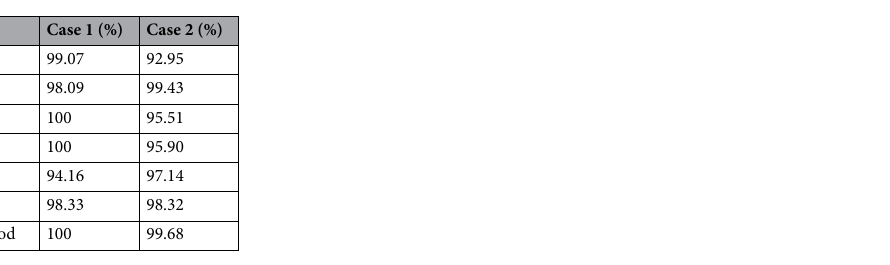
Table 6. Comparison of fault diagnosis accuracy of proposed method to accuracy achieved by previously proposed methods.